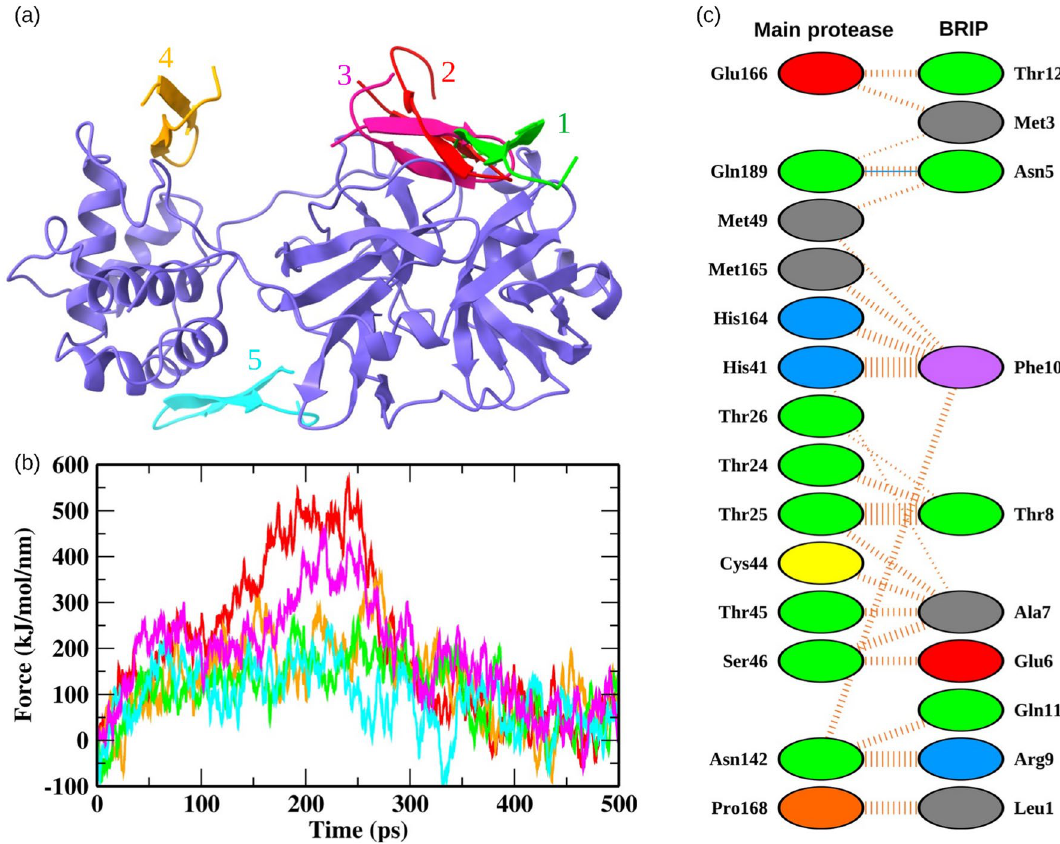
Figure 3. Detection of the protein-peptide binding site. ( a ) BRIP docked on the top five predicted binding sites on M pro . ( b ) The pull force profiles of BRIP attached to the binding pockets of M pro . The pull force trajectories are colored according to the binding poses shown in panel a. ( c ) The M pro -BRIP interactions at the most favorable binding site. The solid blue color lines represent hydrogen bonds, while the striped lines denote non-bonded interactions. The residue color coding scheme: positive (blue), negative (red), neutral (green), aliphatic (gray), aromatic (purple), proline and glycine